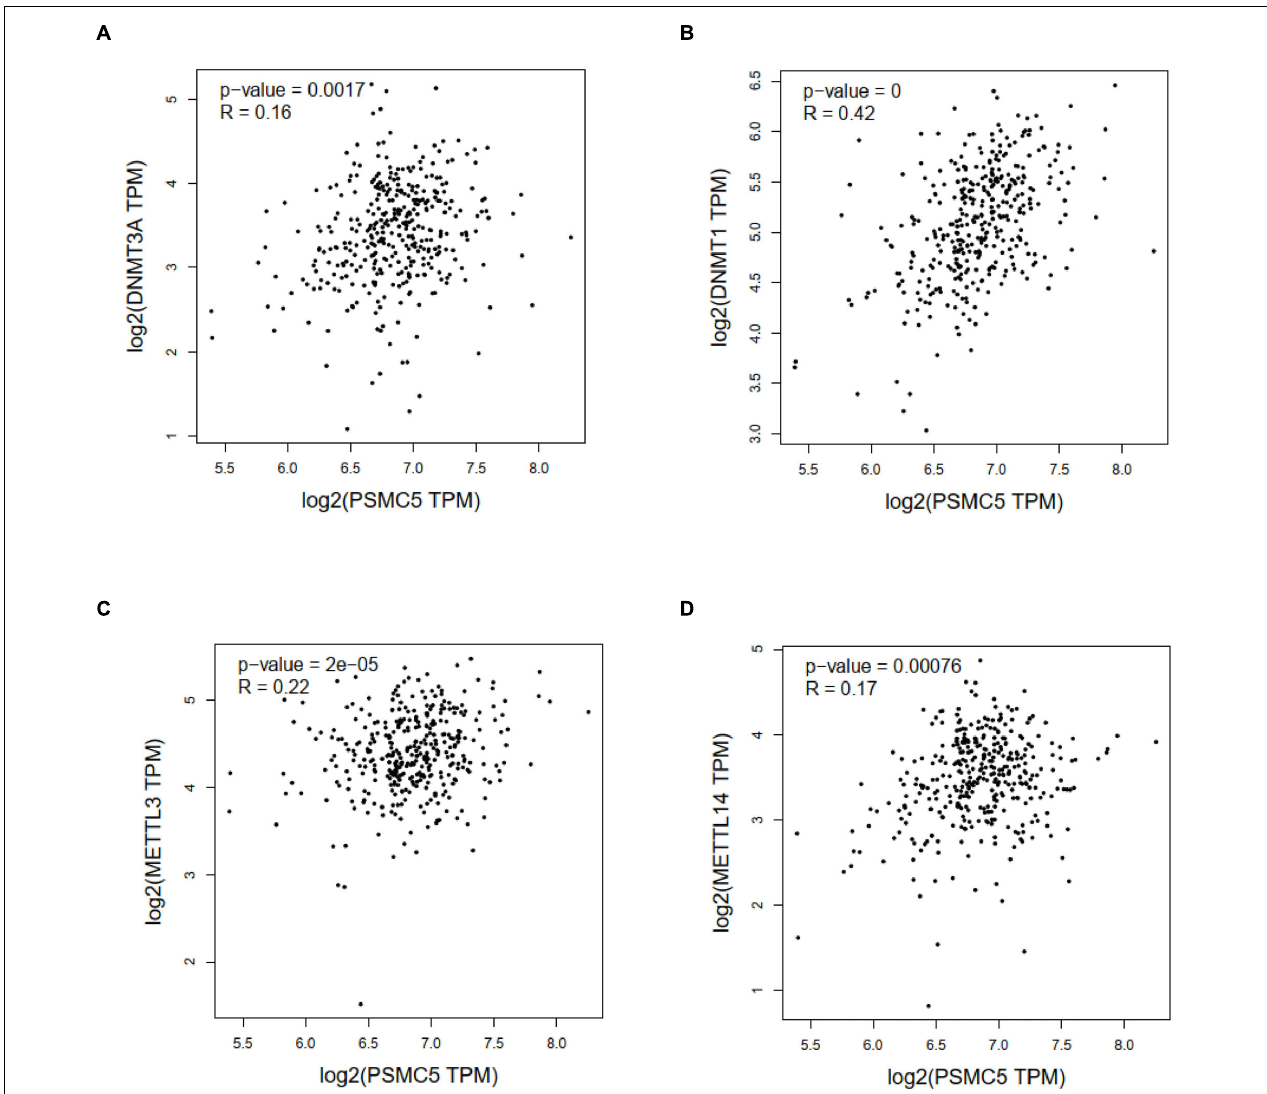
FIGURE 7 | Correlation analysis between PSMC5 and DNA methyltransferase and m 6 A methyltransferases. Correlation between PSMC5 and DNMT1 (A) , DNMT3A (B) , METTL3 (C) , and METTL14 (D)